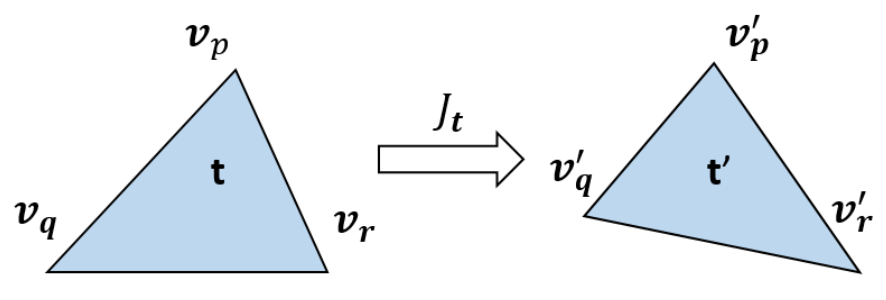
Figure 4. Mapping of a triangle t to the deformed triangle t (cid:48) through an affine transformation J t